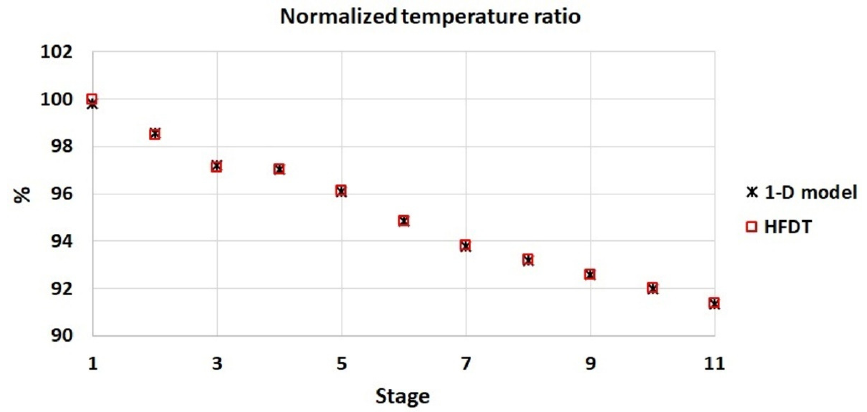
Figure 4. Comparison between stagewise temperature ratio from the 1-D model and HFDT at design point and 100% ω max .